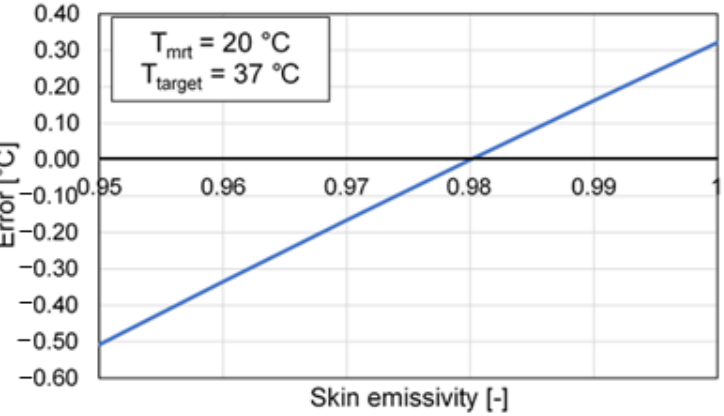
Figure 6. Error trend depending on skin emissivity.